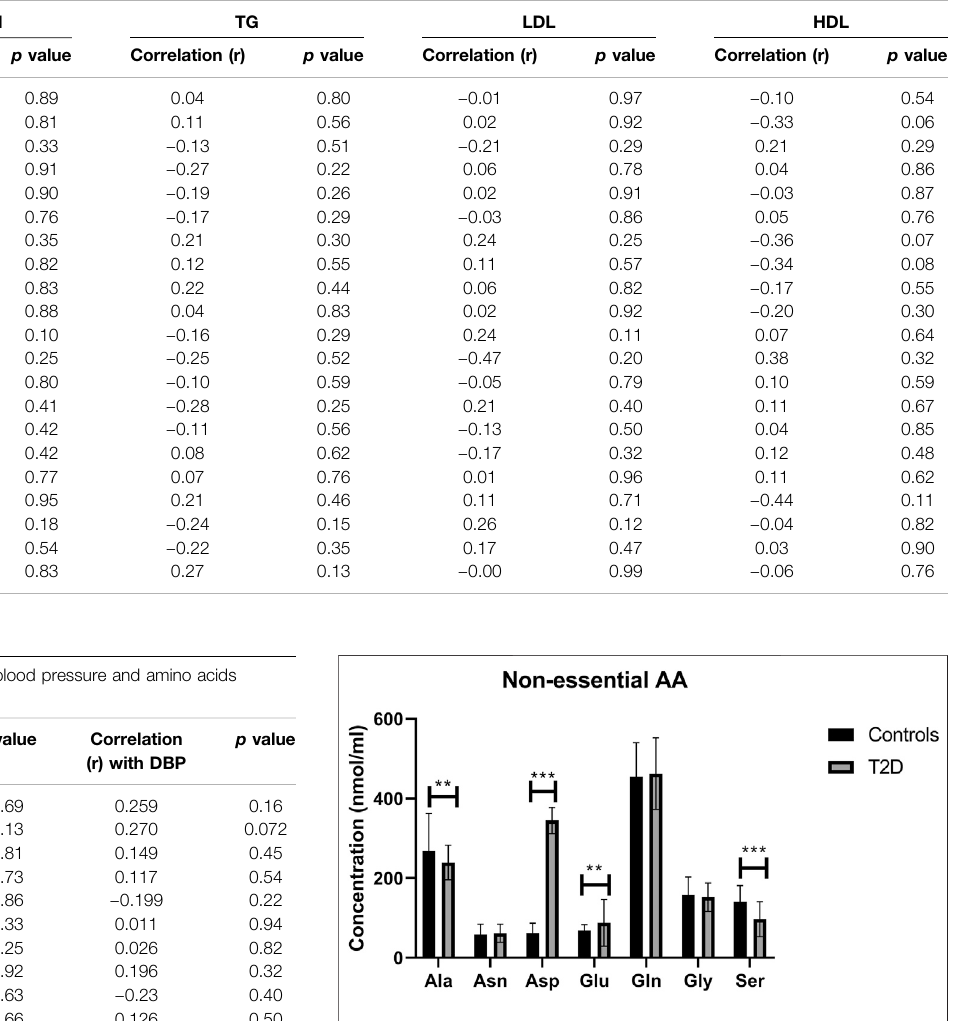
FIGURE3| Plasmaconcentrationofnon-essentialaminoacidsintype2 diabetes (T2D). Ala and Ser concentration was reduced in T2D, whereas Asp andGluconcentrationswereincreasedcomparedtohealthycontrols.Plasma samplesfromT2Dparticipants( n (cid:2) 124)orhealthycontrols( n (cid:2)